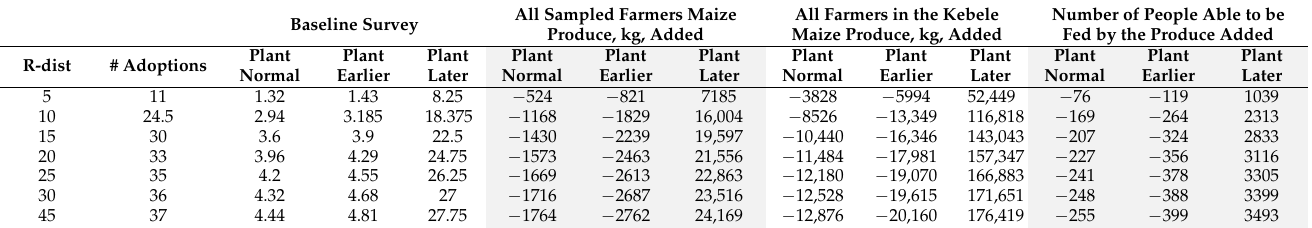
Table A3. Adoption rate of farmers’ interactions with neighbor farmers, crop productivities of adopted numbers, and number of people able to be fed under less rain